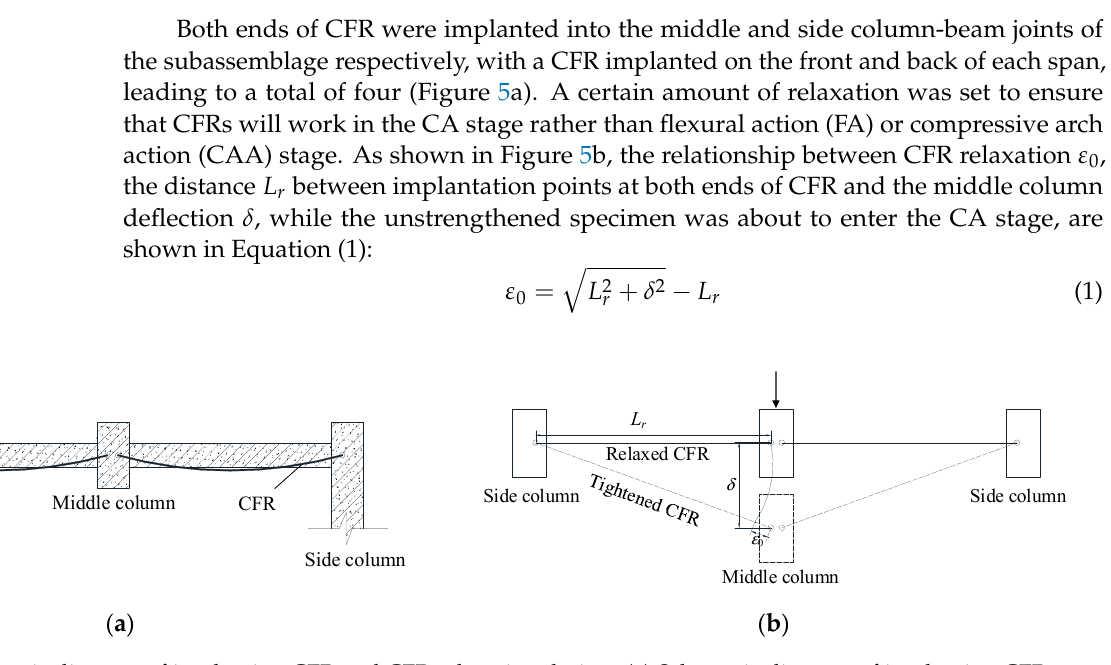
Figure 5. Schematic diagram of implanting CFR and CFR relaxation design: ( a ) Schematic diagram of implanting CFR; ( b ) CFR relaxation design.